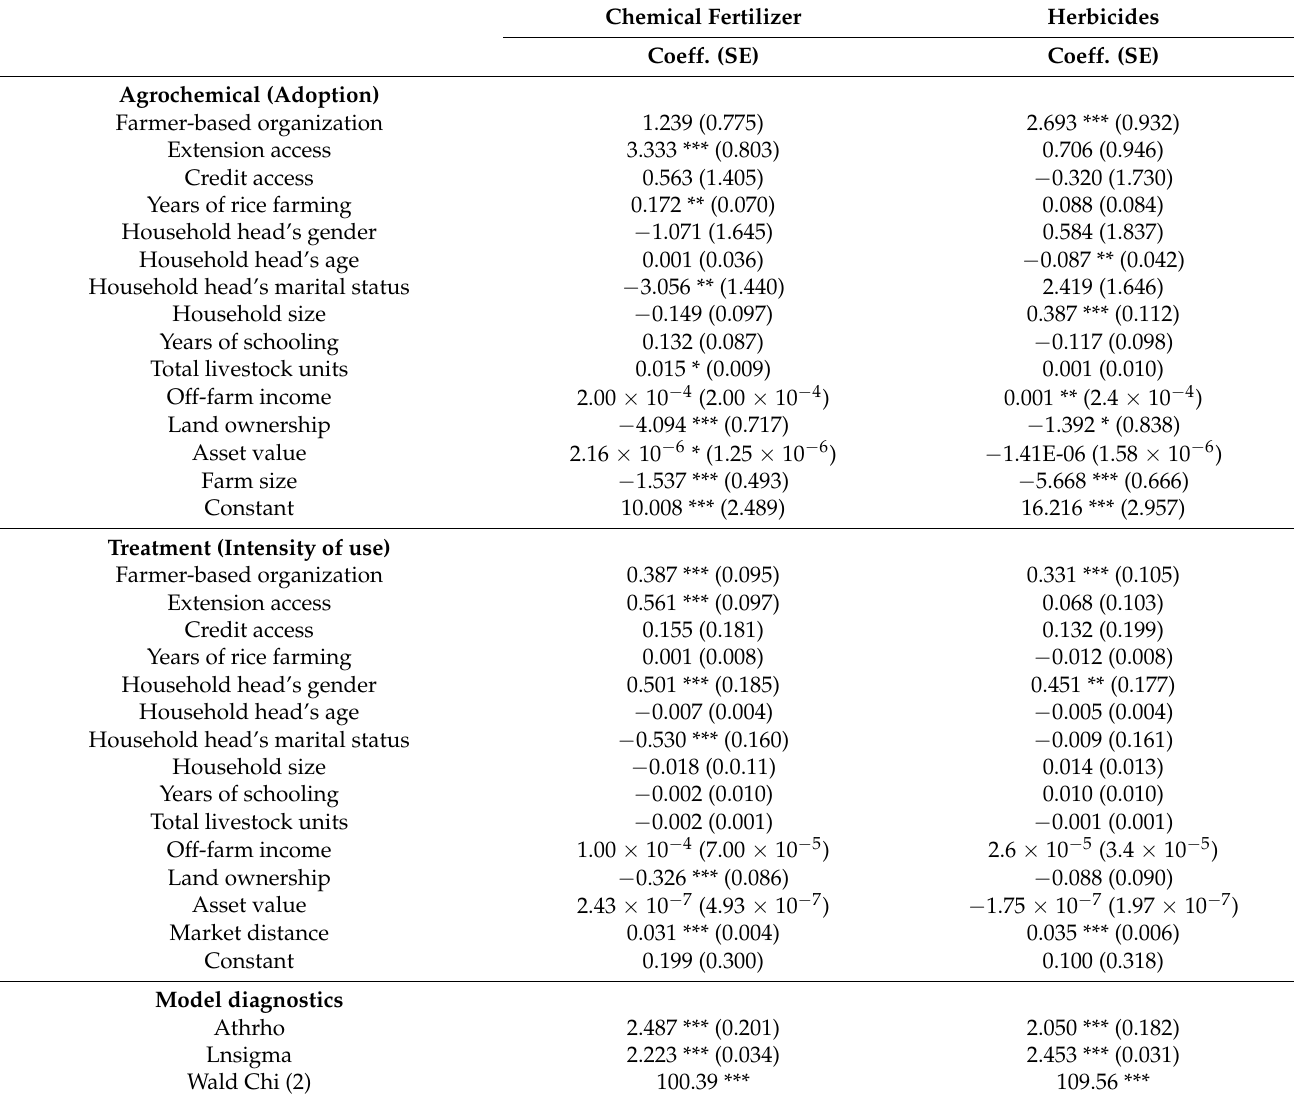
Table 3. Heckman sample selection model results for agrochemical